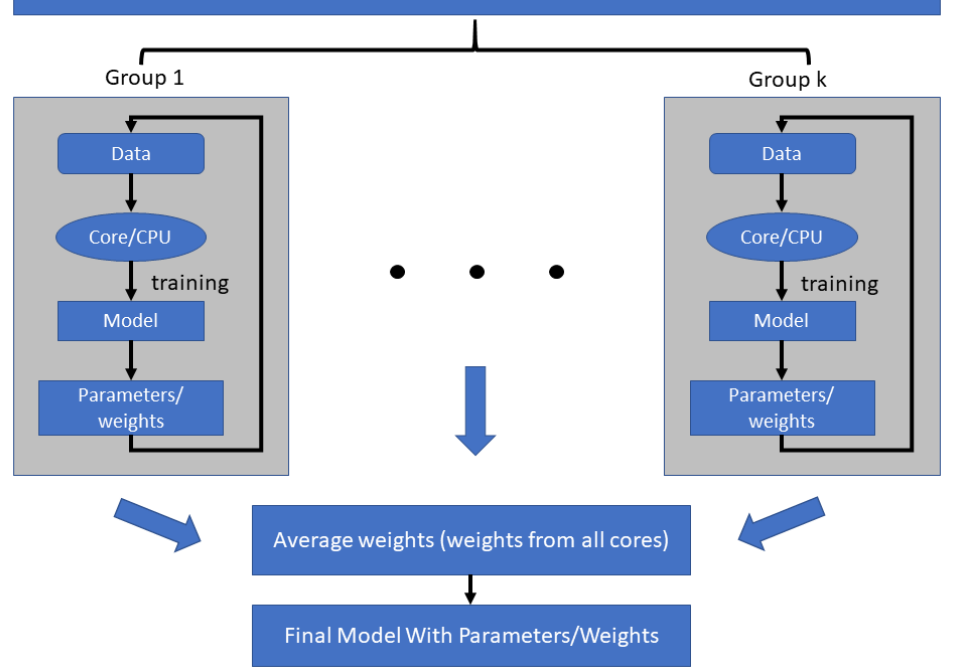
Figure 9. Distributed training of surrogate models.